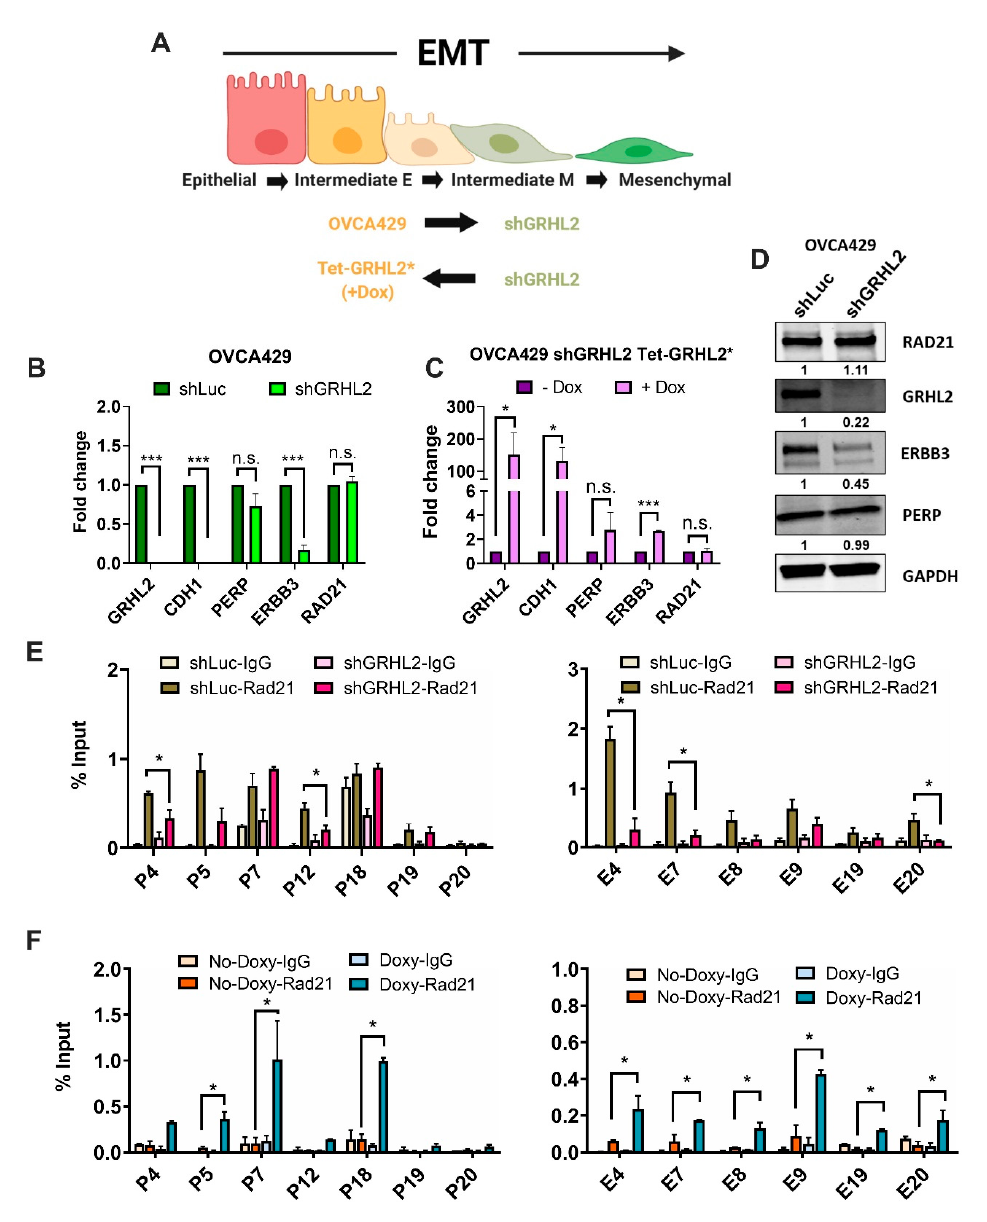
Figure4. GRHL2levelspartiallydetermineRAD21recruitmenton PERP and ERBB3 loci. ( A )Illustration Figure 4. GRHL2 levels partially determine RAD21 recruitment on PERP and ERBB3 loci. ( A ) showingtheEMTspectrummodel: OVCA429GRHL2-knockdown(shGRHL2)andOVCA429shGRHL2 Illustration showing the EMT spectrum model: OVCA429 GRHL2-knockdown (shGRHL2) and OVCA429 shGRHL2 Tet-GRHL2* (rescue) cells. Illustration created with Biorender.com. ( B,C ) Tet-GRHL2* (rescue) cells. Illustration created with Biorender.com. ( B , C ) Expression levels of indicated Expression levels of indicated genes in control (shLuc) and GRHL2-knockdown (shGRHL2) genes in control (shLuc) and GRHL2-knockdown (shGRHL2) OVCA429 cells ( B ) and OVCA429 OVCA429 cells ( B ) and OVCA429 shGRHL2 Tet-GRHL2* ( C ) cells with/without 96-h doxycycline- shGRHL2 Tet-GRHL2* ( C ) cells with / without 96-h doxycycline-induced GRHL2 overexpression as induced GRHL2 overexpression as analyzed through RT-qPCR. Results for at least three biological analyzed through RT-qPCR. Results for at least three biological replicates were shown ± SEM. Unpaired replicates were shown ± SEM. Unpaired t -tests were performed; * p < 0.05, ** p < 0.01, and *** p < 0.001. t -tests were performed; * p < 0.05, ** p < 0.01, and *** p < 0.001. ( D ) Western blots of RAD21, GRHL2, ( D ) Western blots of RAD21, GRHL2, ERBB3, and PERP in control (shLuc) and GRHL2-knockdown ERBB3, and PERP in control (shLuc) and GRHL2-knockdown (shGRHL2) OVCA429 cells. GAPDH (shGRHL2) OVCA429 cells. GAPDH was used as a loading control in Western blotting. Full-length was used as a loading control in Western blotting. Full-length blots are available in Figure S3 from blots are available in Figure S3 from Supplementary Material. ( E , F ) ChIP-qPCR plots showing RAD21 Supplementary Material. ( E , F ) ChIP-qPCR plots showing RAD21 enrichment levels on PERP ( left ) and enrichment levels on PERP (left) and ERBB3 (right) loci measured in control (shLuc), GRHL2- ERBB3 ( right ) loci measured in control (shLuc), GRHL2-knockdown (shGRHL2) OVCA429 cells ( E ), knockdown (shGRHL2) OVCA429 cells ( E ), and OVCA429 shGRHL2 Tet-GRHL2* (rescue) cells and OVCA429 shGRHL2 Tet-GRHL2* (rescue) cells with / without 96-h doxycycline-induced GRHL2 overexpression ( F ). Signals were normalized to input DNA (1%) and plotted as enrichments relative to its respective IgG control. Results for at least two biological replicates were shown ± SEM. Unpaired t -tests were performed to compute statistical significance; * p <